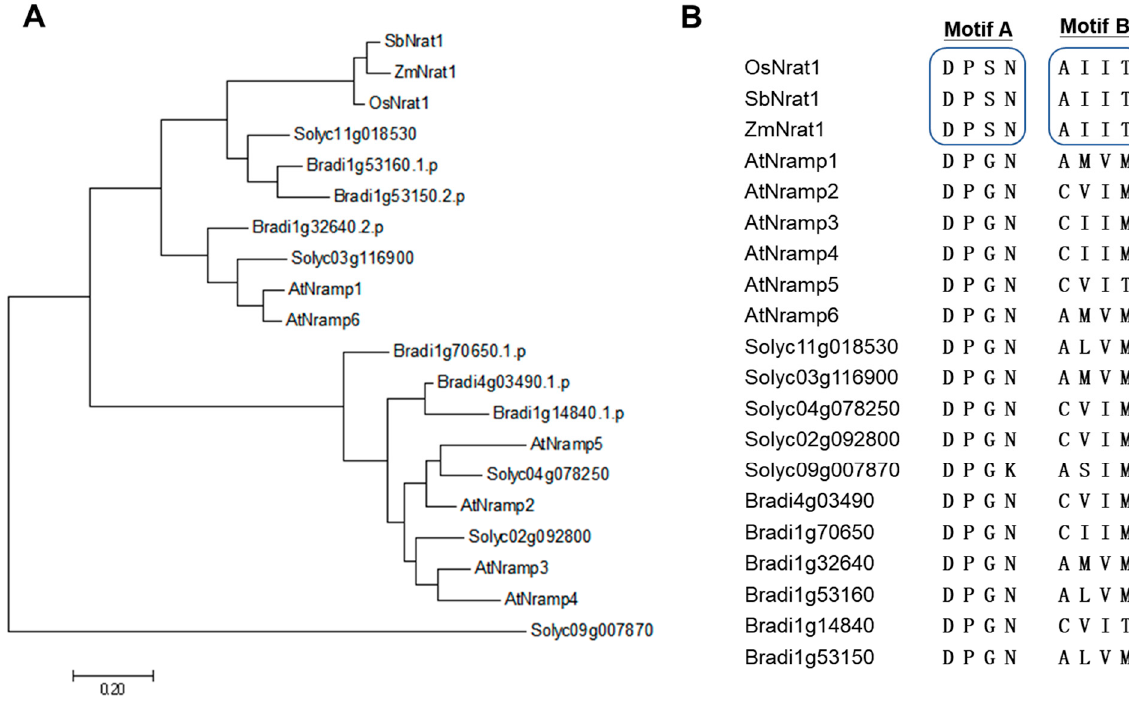
Figure 2. Phylogenetic and motif analysis for the 20 plant metal transporters of the Nramp family. ( A ) An unrooted phylogenetic tree was built by MEGA7. ( B ) Sequence alignment of the two signature motifs of the 20 plant Nramp transporters. The 20 Nramp transporters are rice OsNrat1 (XP_015625418), Sorghum SbNrat1 (XP_002451480), Maize ZmNrat1 (NP_001334019), six Arabidopsis Nramp proteins, five tomato Nramp proteins, and six Brachypodium distachyon Nramp